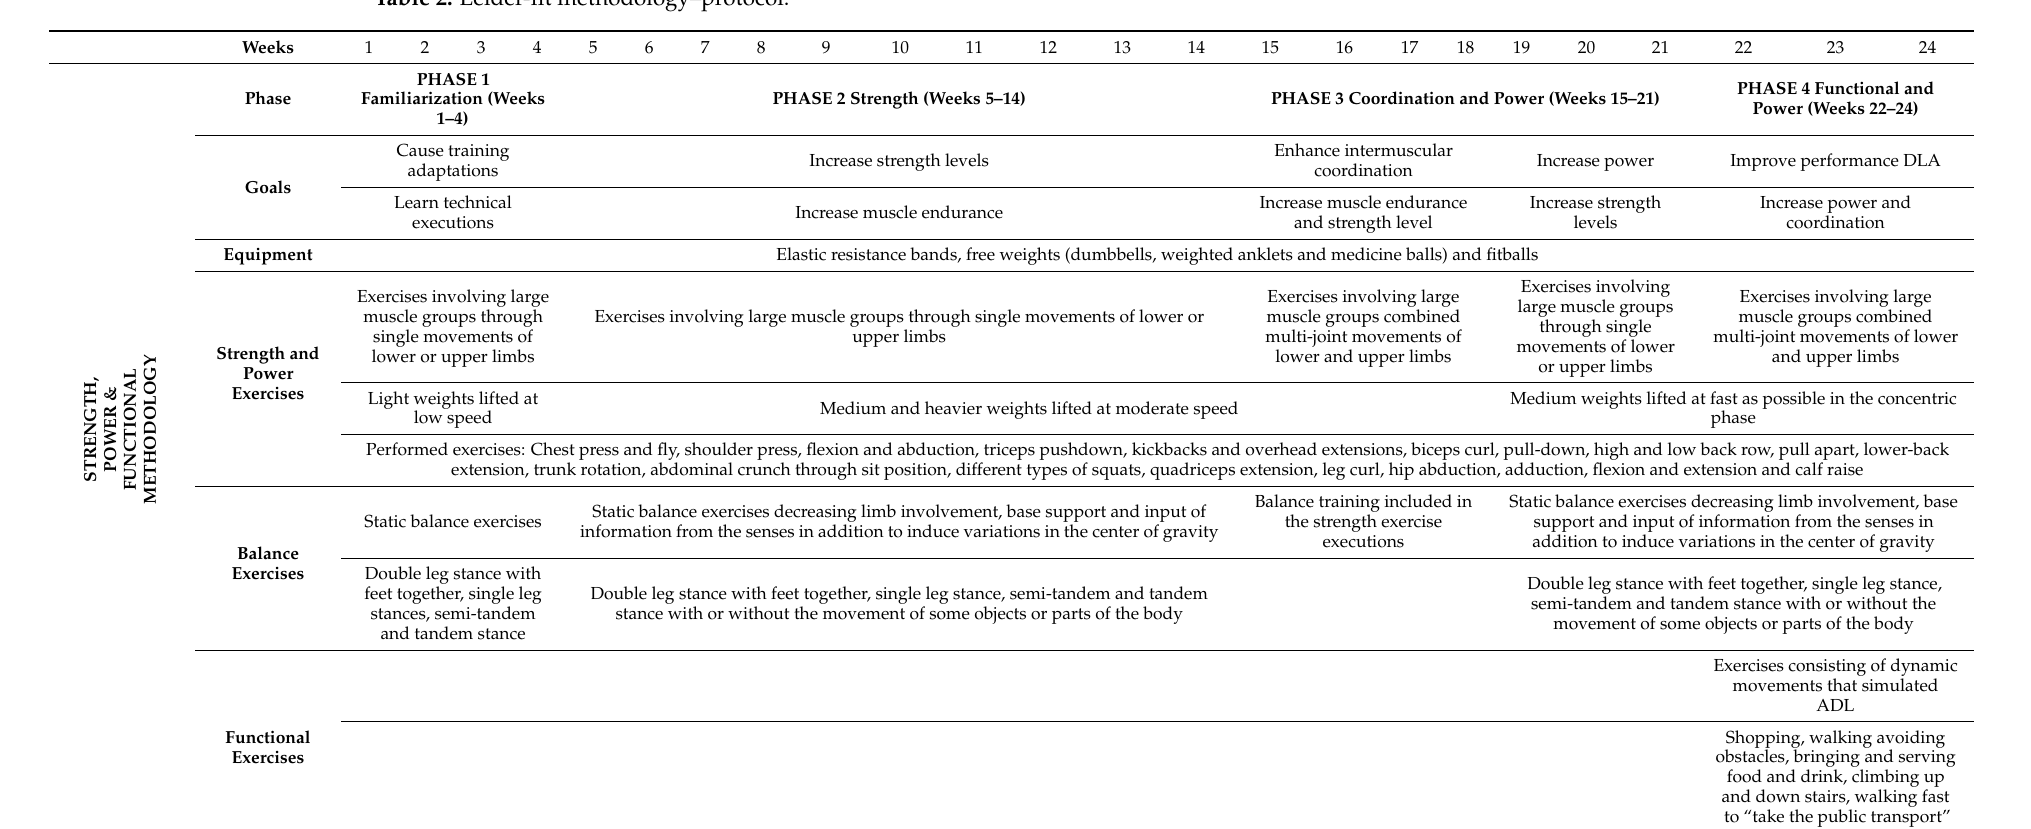
Table 2. Eelder-fit